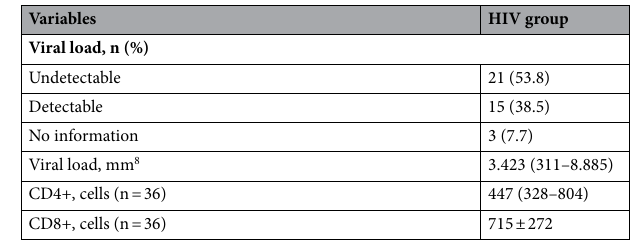
Table 3. Clinical variables of the pregnant patients infected with HIV (n = 39). The categorical data are expressed by absolute (n) and relative (%) frequencies. The continuous data are expressed by median and percentiles 25 and 75 and by mean and standard